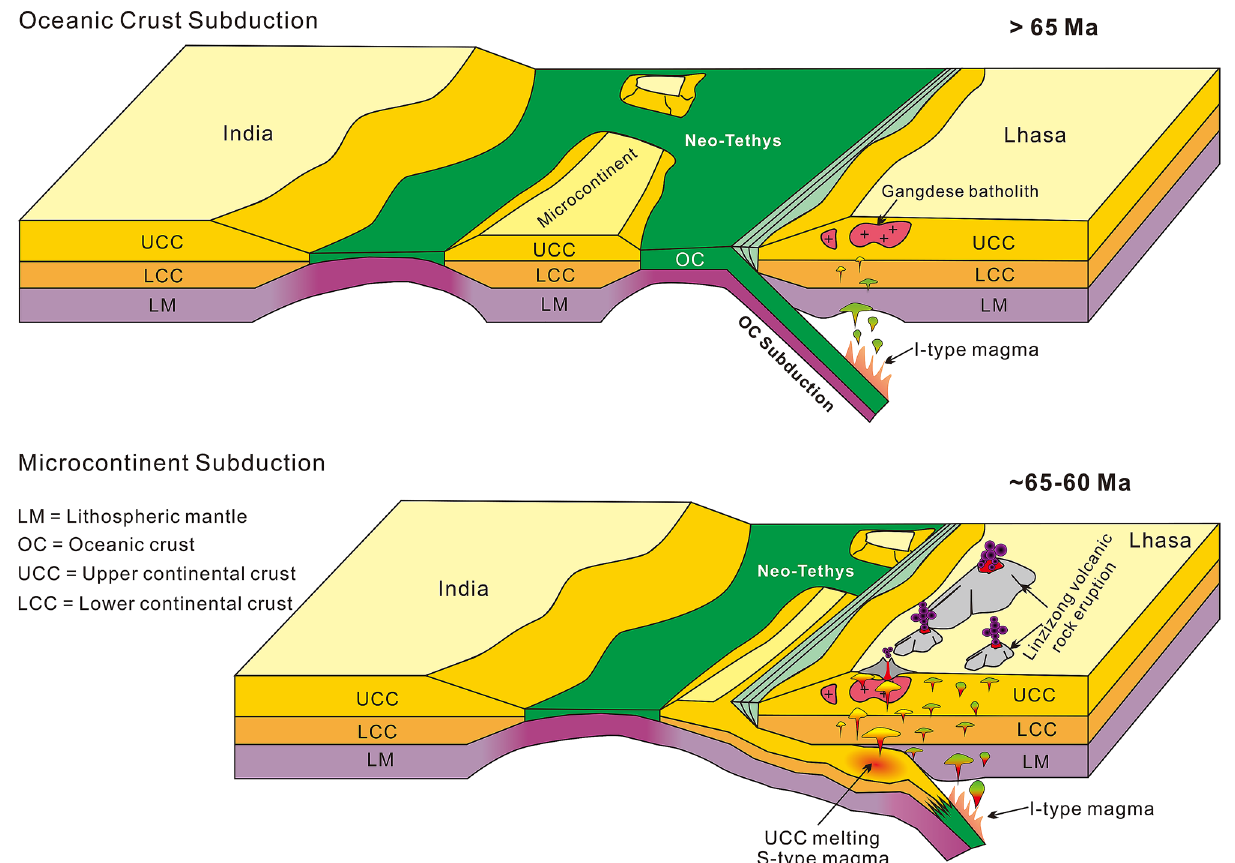
Figure 9. Conceptual model showing the subduction of the microcontinent and the formation of S-type magma. Not drawn to scale. See text for